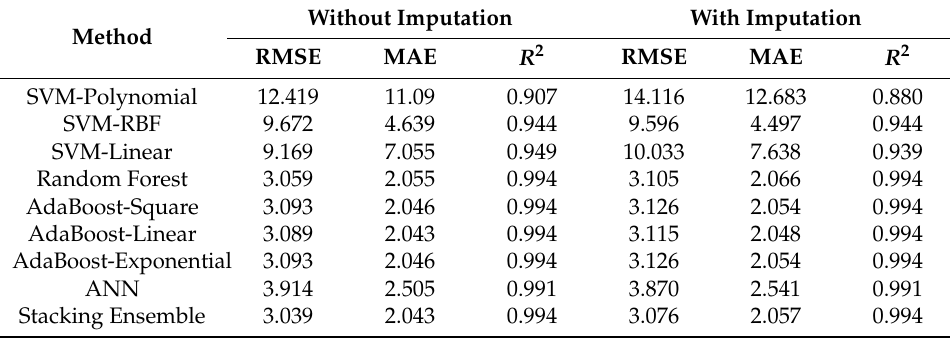
Table 7. Results of ML Algorithms for Changhua F1-AQI Prediction.